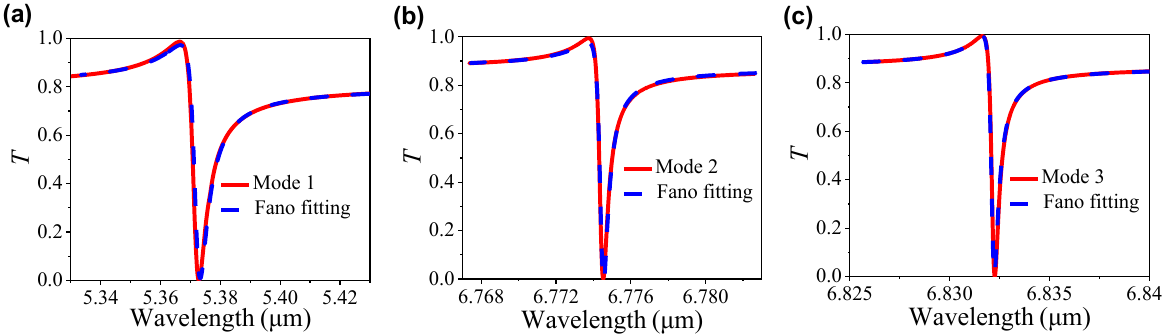
Figure 10: Comparison of the Fano fitting and simulation results. (a), (b), and (c) are Fano fittings of the three modes when k = 0.9. The solid curves are simulation results, and the dashed curves are Fano fitting